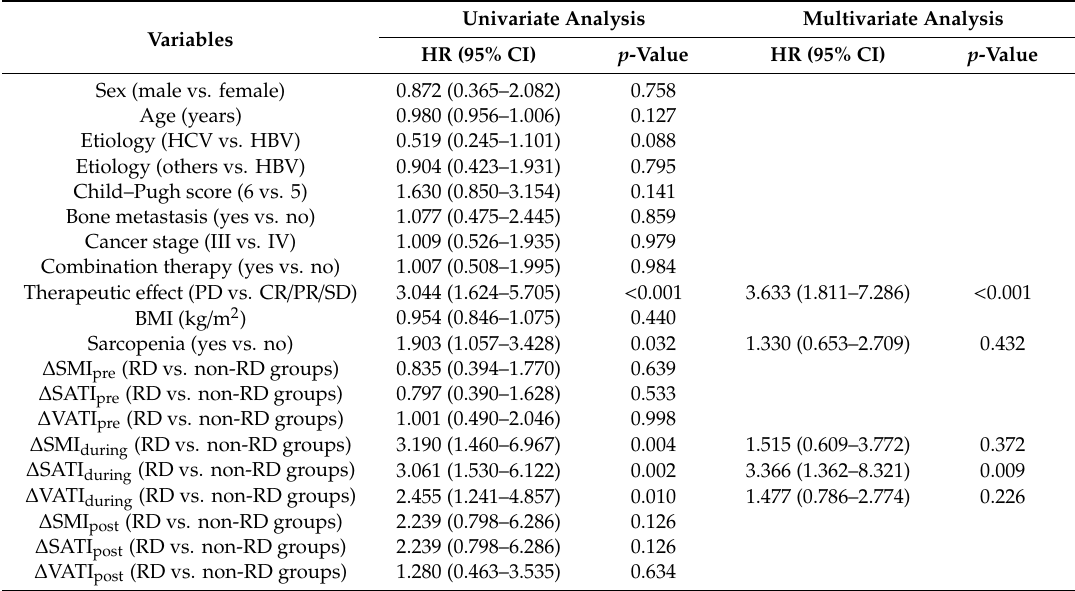
Table 3. Univariate and multivariate analyses of possible prognostic factors in the patients, according to the Cox proportional-hazards model.